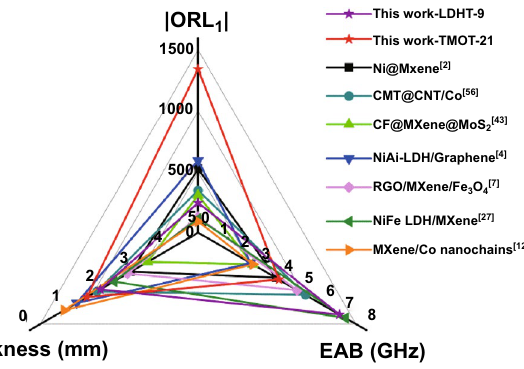
Fig. 9 Schematic illustration of microwave absorption mechanism for TMOT